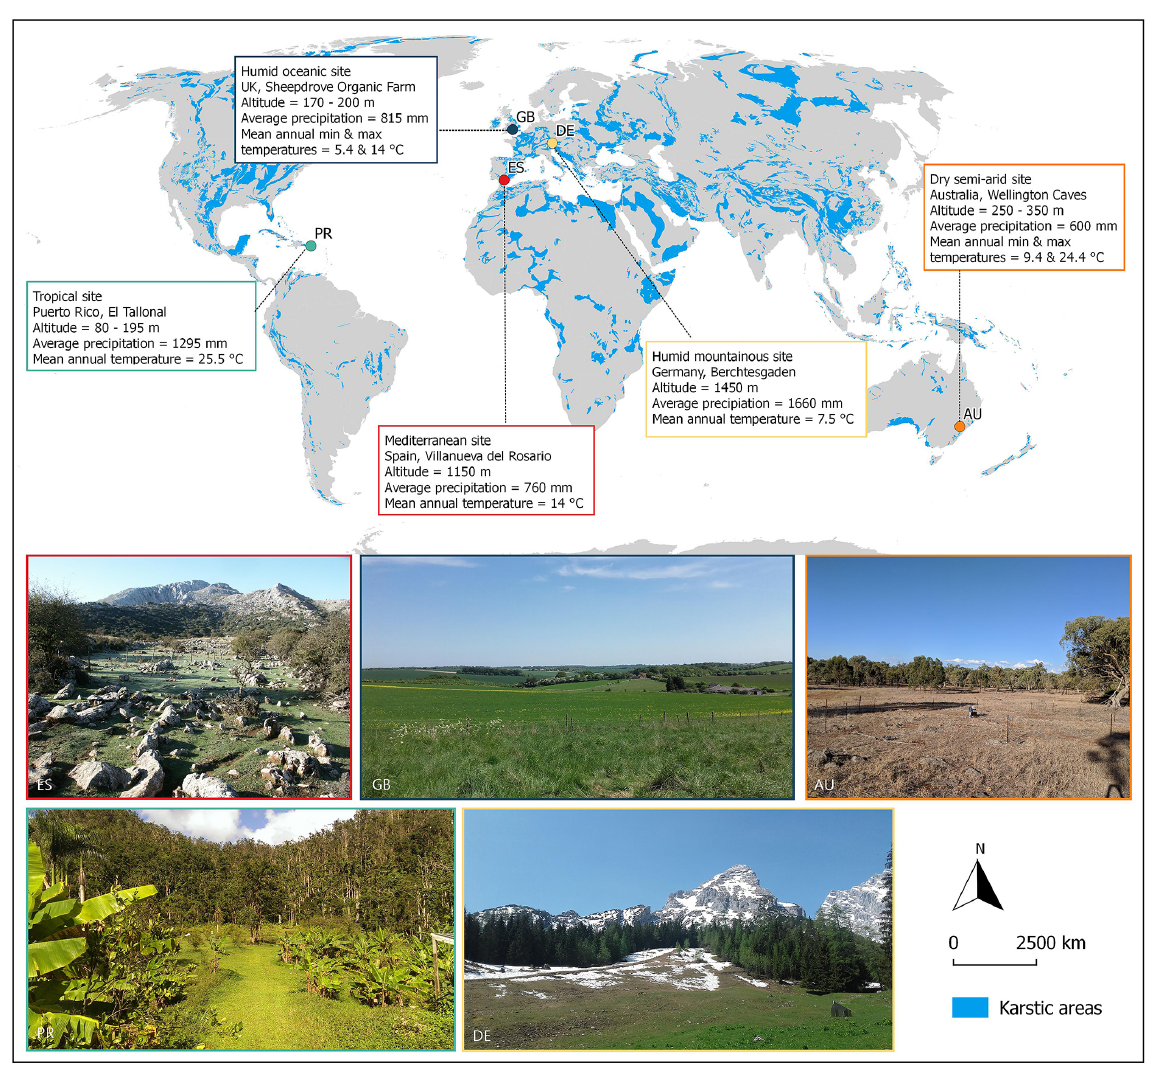
Figure 1. Locations and pictures of the five sites – carbonate rock outcrops derived from the World Karst Aquifer Map (Chen et al.,